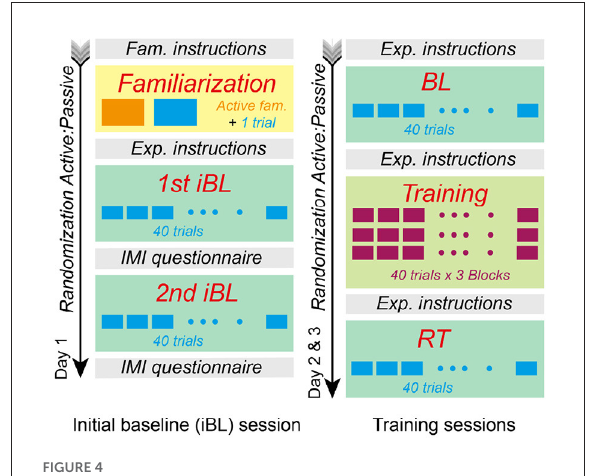
FIGURE4 Experimental protocol. Participants completed three sessions on different days. The first session included familiarization and an initial baseline (iBL) for each condition. Half of the participants (randomly allocated) performed the first iBL in the active condition, whereas the second half had the passive condition first. We performed a second randomization to define the order of the training conditions during sessions 2 and 3. Each second and third session consisted of baseline (BL), training, and retention (RT) with either, passive or active conditions.